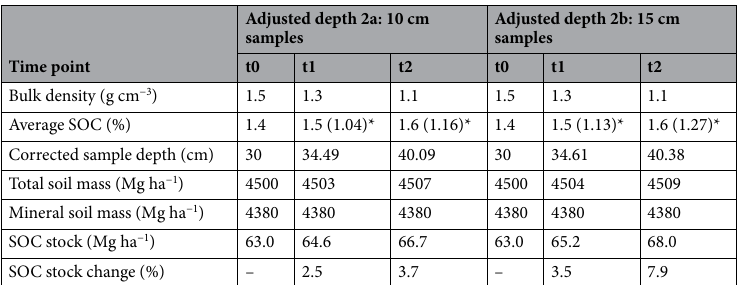
Table 4. Scenario 2: Changes in SOC stocks, total soil mass, and mineral soil mass using adjusted depth (ESM correction) approach, with split sampling intervals of 10 cm (scenario 2a) and 15 cm (scenario 2b) intervals at three-time points. *Indicates the average SOC concentration in the lowest sample depth interval.